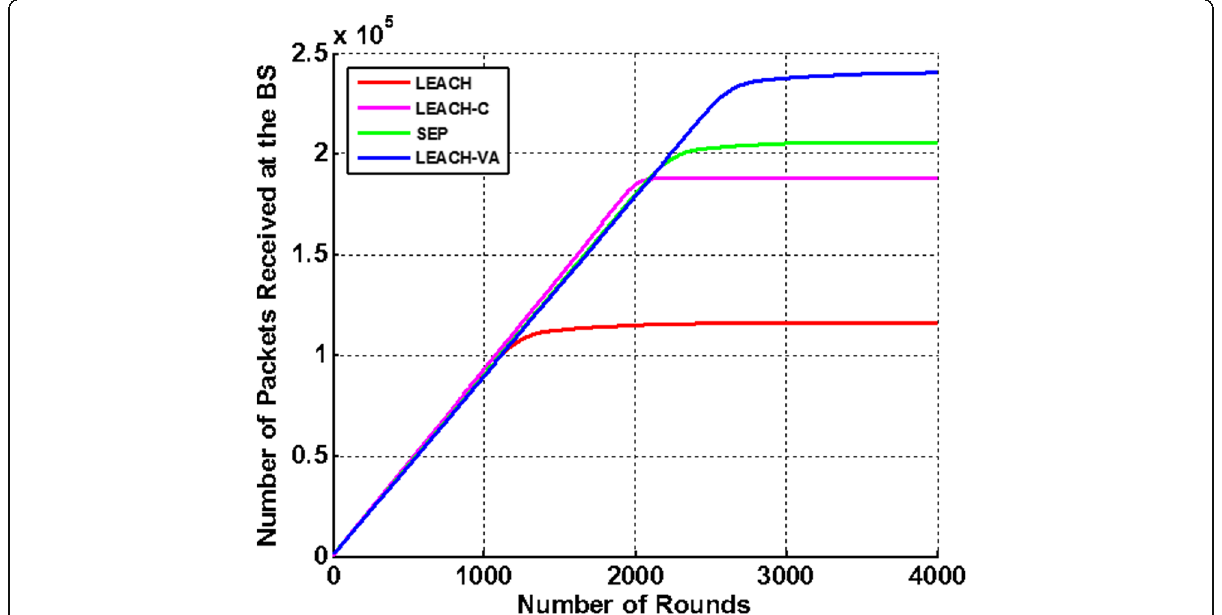
Fig. 7 Round versus a number of packets received at the